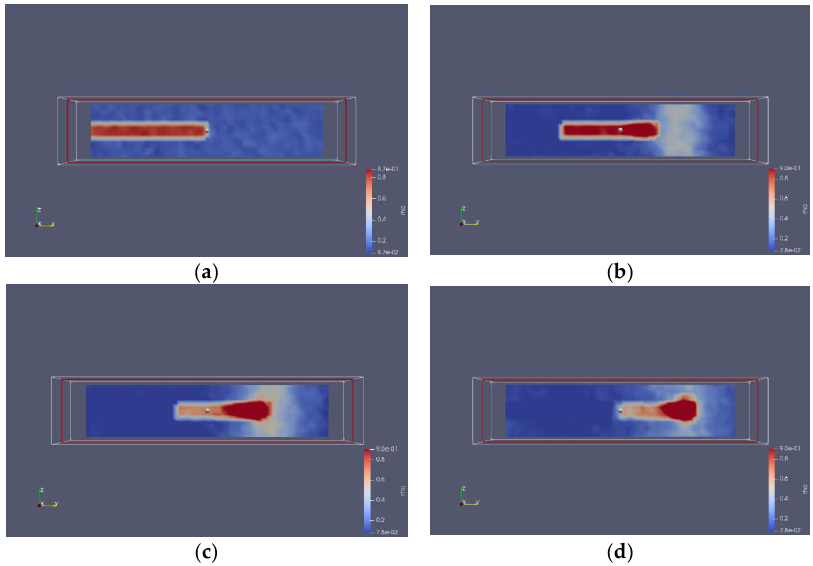
Figure 13. Density profile (unit: kg/m 3 ) of nitrogen jet (7.5 MPa, 120 K) sprayed into supercritical argon environment (5.5 MPa, 200 K): ( a ) t = t 0 ; ( b ) t = t 0 + 25 ps; ( c ) t = t 0 + 50ps; ( d ) t = t 0 + 100 ps.